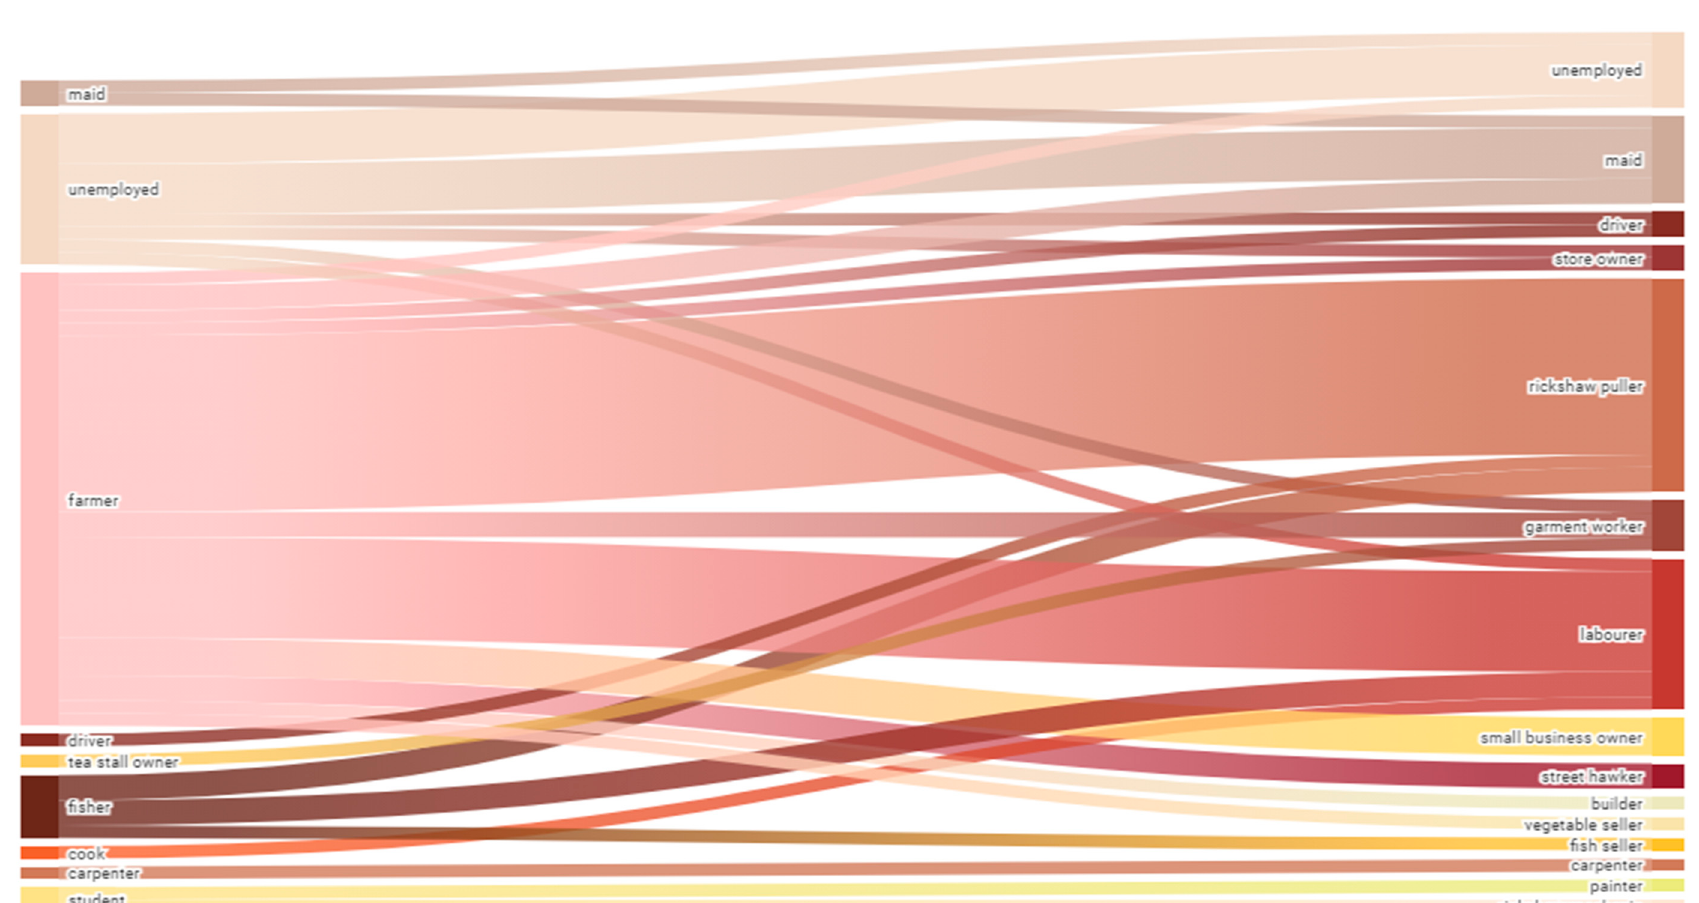
Figure 2. Change in employment pre-migration (origin) to post-migration (destination). Sankey Diagram: The left represents the occupations of participants before migration (at the origin in Bhola) and on the right, the occupations of participants post-migration (at destination in Dhaka). The width of the streams represents the number of participants involved in that transition. A few participants had more than one occupation at origin and destination, in which case, the transition stream was duplicated.